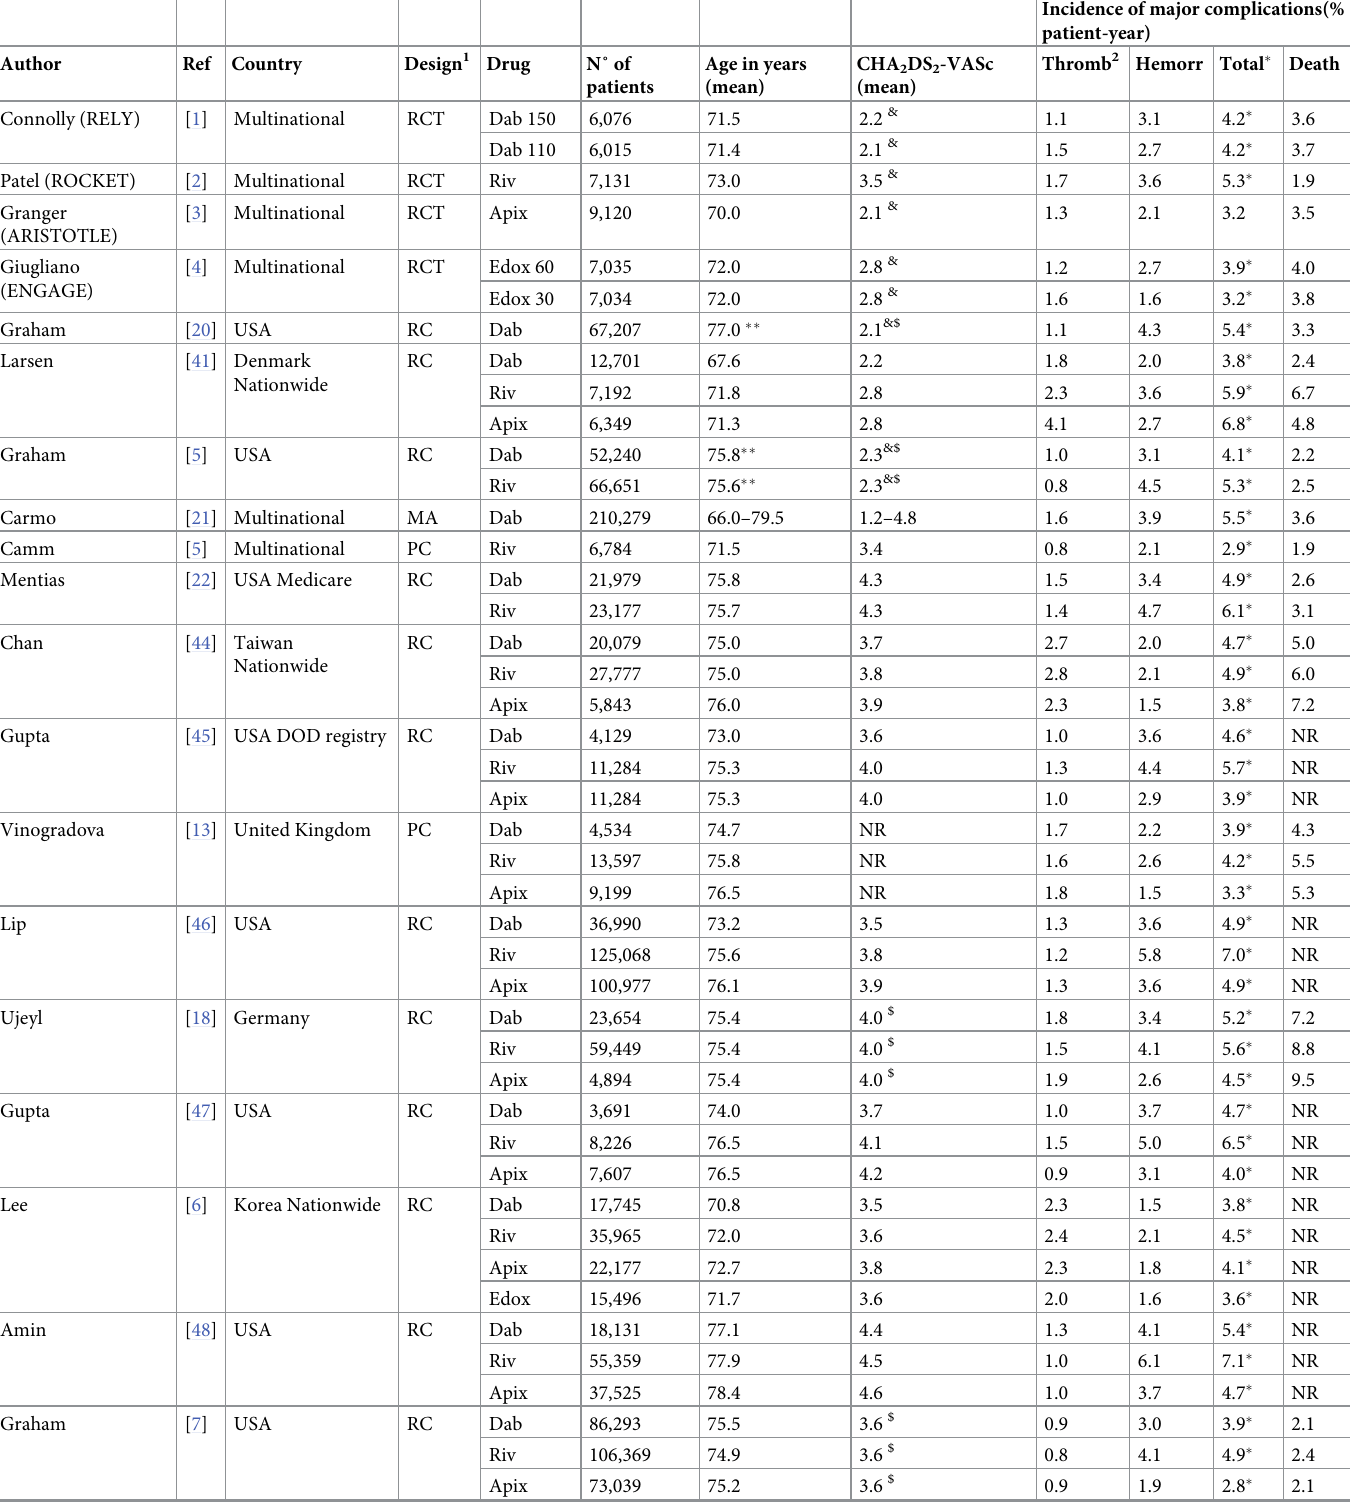
Table 4. Main outcomes with DOACs from studies in real practice or RCTs, reporting a lower or similar incidence of major complications than